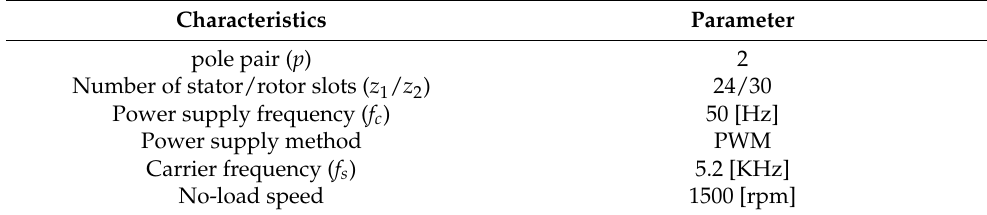
Table 1. Testing induction motor parameters. Figure 8. Induction motor noise test: ( a ) induction motor noise signal acquisition; ( b ) equipment.